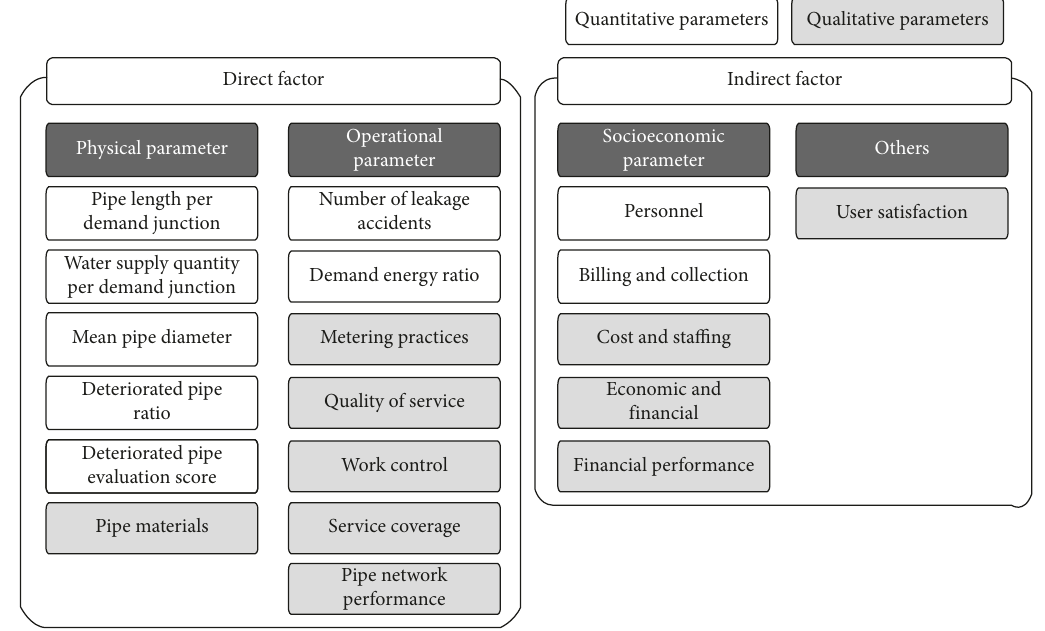
Figure 1: Classification of leading parameters for NRW management